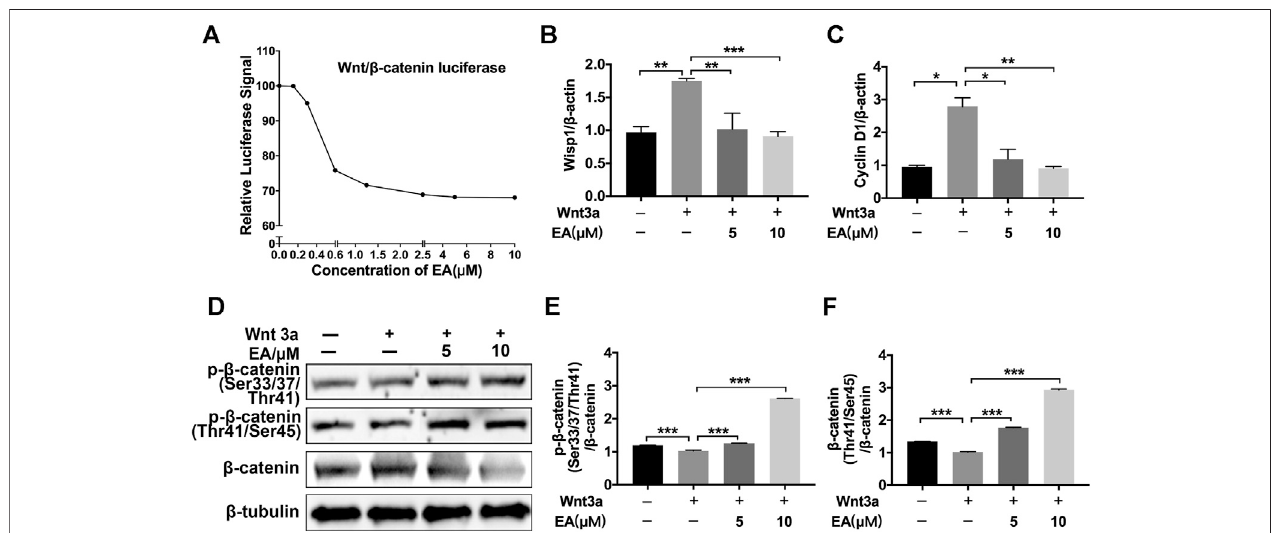
FIGURE2| EllagicacidinhibitsWnt/ β -cateninsignalingpathway (A) NIH-3T3cellsweretransfectedwiththeTOPFlashplasmids.After18 hoftransfection,thecells were treated with Wnt3a (100 ng/ml) and/or Ellagic acid at various concentrations for 8 h and then lyzed for luciferase assays (B , C) NaCl-PPF cells were incubated with Ellagicacid(5 µM,10 µM)and/or Wnt3a (100 ng/ml)for 12 htoanalyzethe mRNAlevels ofWisp1 and Cyclin D1byusing quantitativereal-time PCR (D) NaCl-PPF cells were treated with Ellagic acid (5 µM, 10 µM) and/or Wnt3a (100 ng/ml) for 4 h, p- β -catenin (Ser33/37/Thr41) and p- β -catenin (Thr41/Ser45) were detected by Western blot. Densitometric analyses were shown beside. Data ( Figures 2B – F ) are means ± Standard Error of Mean, n (cid:1) 3, * p < 0.05, ** p < 0.01, *** p < 0.001, and NS: nonsigni fi cant (one-way ANOVA). β -tubulin was used as a loading